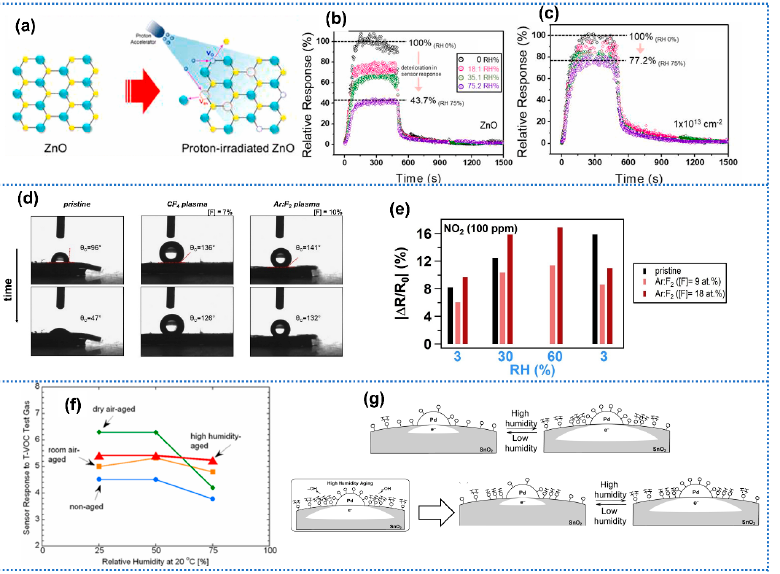
Figure 7. ( a ) Schematic diagram of proton-irradiated ZnO gas sensors. Dynamic relative response plots of different gas sensors to 10 ppm NO 2 at 300 °C under various humidity conditions. ( b ) Pristine ZnO and ( c ) 1 × 10 13 protons/cm 2 proton-irradiated ZnO. Reprinted with permission from Ref. [107]. Copyright 2021, Elsevier. ( d ) Water contact angle of pristine carbon nanotubes and fluorinated carbon nanotubes in 30 s. ( e ) The relative sensor response to 100 ppm NO 2 at variable humidity conditions for pristine and Ar:F 2 plasma fluorinated carbon nanotubes with different fluorination yields. Reprinted with permission from Ref. [108]. Copyright 2019, Elsevier. ( f ) Non, dry air, room air, and high-humidity aged Pd/SnO 2 under different humidity conditions and 400 g/m 3 T–VOC test gas concentration. ( g ) Schematic images of the surface conditions of Pd-loading area on the non- aged Pd/SnO 2 and high-humidity aged Pd/SnO 2 . Reprinted with permission from Ref. [111]. Copy- right 2010, MDPI.